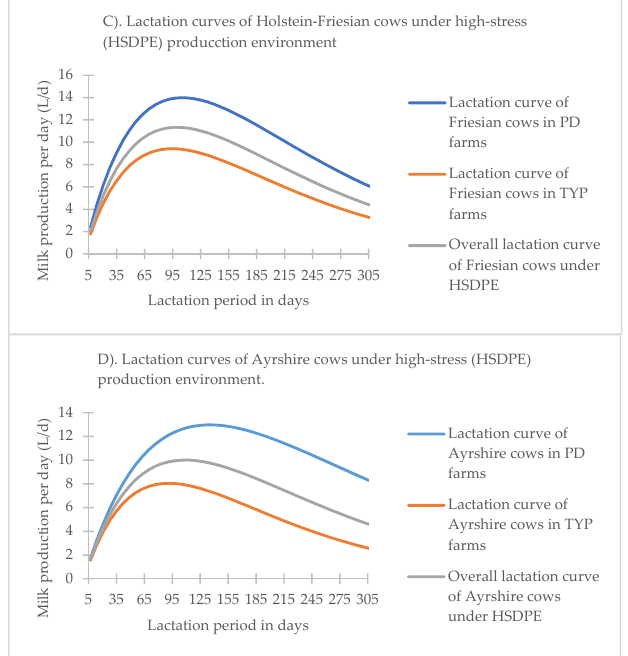
Figure 4. Lactation curves of dairy cows managed in positive deviants (PD) and typical (TYP) farms nested within low- and high-stress production environments: ( A , C ). Holstein–Friesian cows and ( B , D ). Ayrshire cows. The farms which attain consistent outstanding performance are labelled positive deviants while the average performers are labelled typical farms. Table 4. Means (LSMEANS ± SE) of lactation length and persistency for Holstein–Friesian and Ayrshire cows managed in positive deviants and typical farms nested within low- and high-stress production